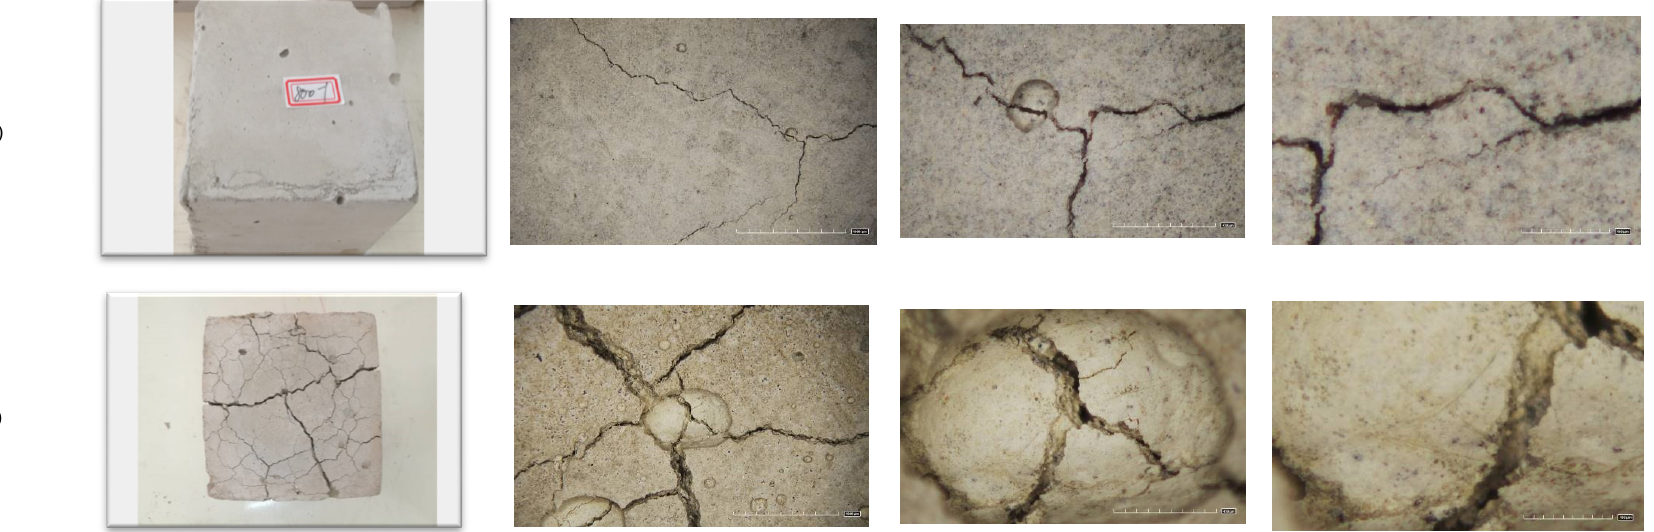
◦ C, ( b ) 200 ◦ C, ( c ) 400 ◦ C, ( d ) 600 ◦ C, ( e ) 800 ◦ C, ( f ) 1200 ◦